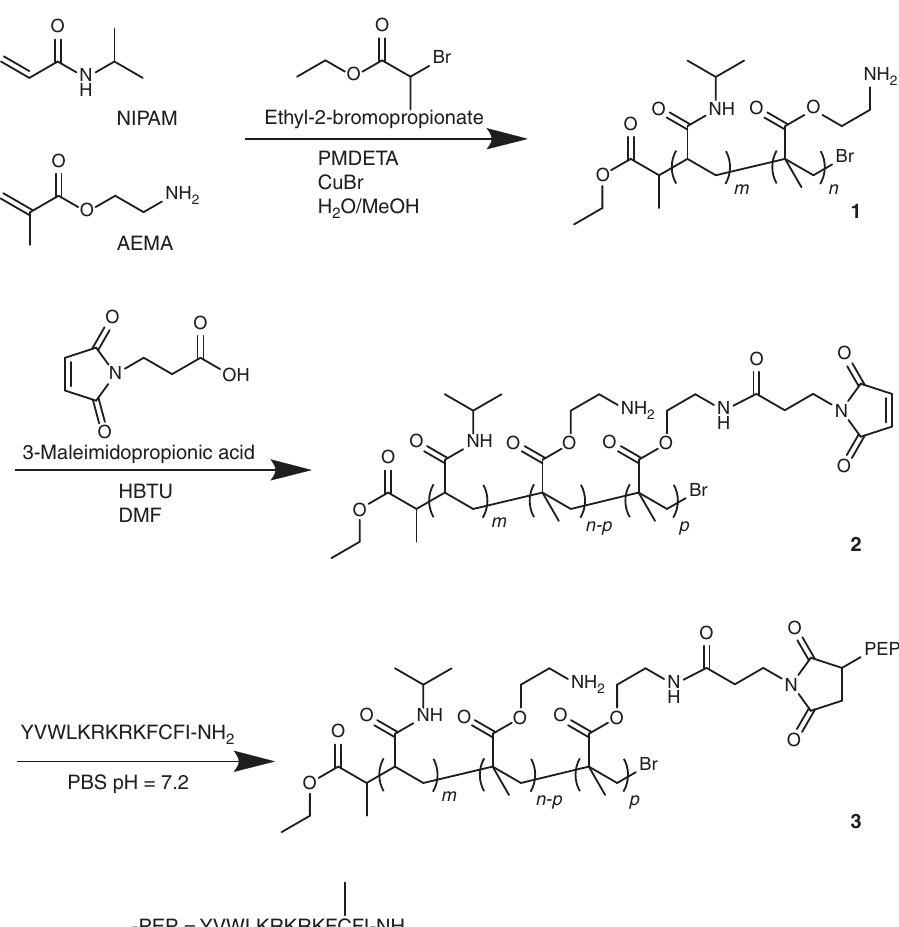
Fig. 2 Synthetic steps for the preparation of copolymer 3 . From GPC and 1 H NMR results, m ~ 77, n ~ 11 and p ~